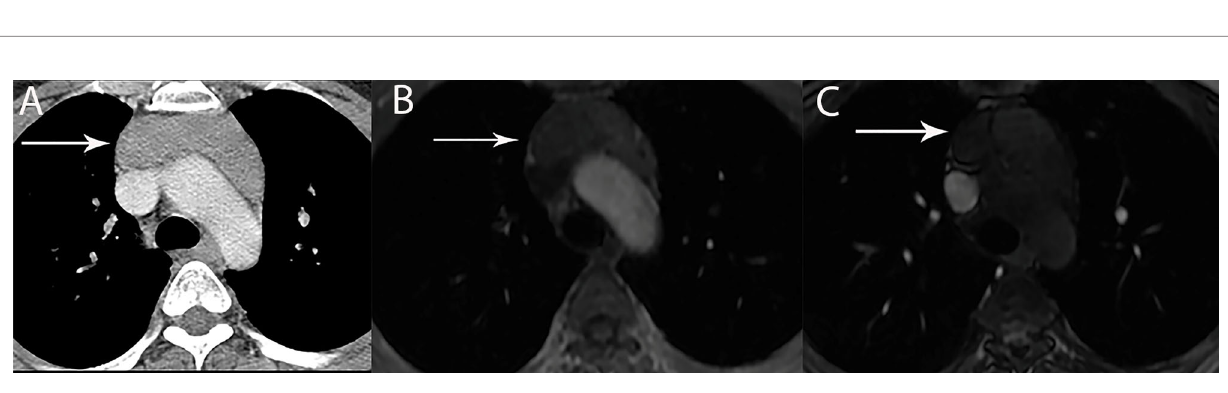
FIGURE 7 | 42 year old woman with Grave ’ s disease and lymphoid thymic hyperplasia. (A) Contrast-enhanced CT shows mass-like thymic enlargement (arrow). With such an appearance, thymic hyperplasia, a thymic epithelial neoplasm or lymphoma involvement of the thymus cannot be distinguished one from another. (B, C) MRI with in and out of phase imaging shows drop in signal intensity consistent with thymic hyperplasia (arrow), obviating the need for further investigation or